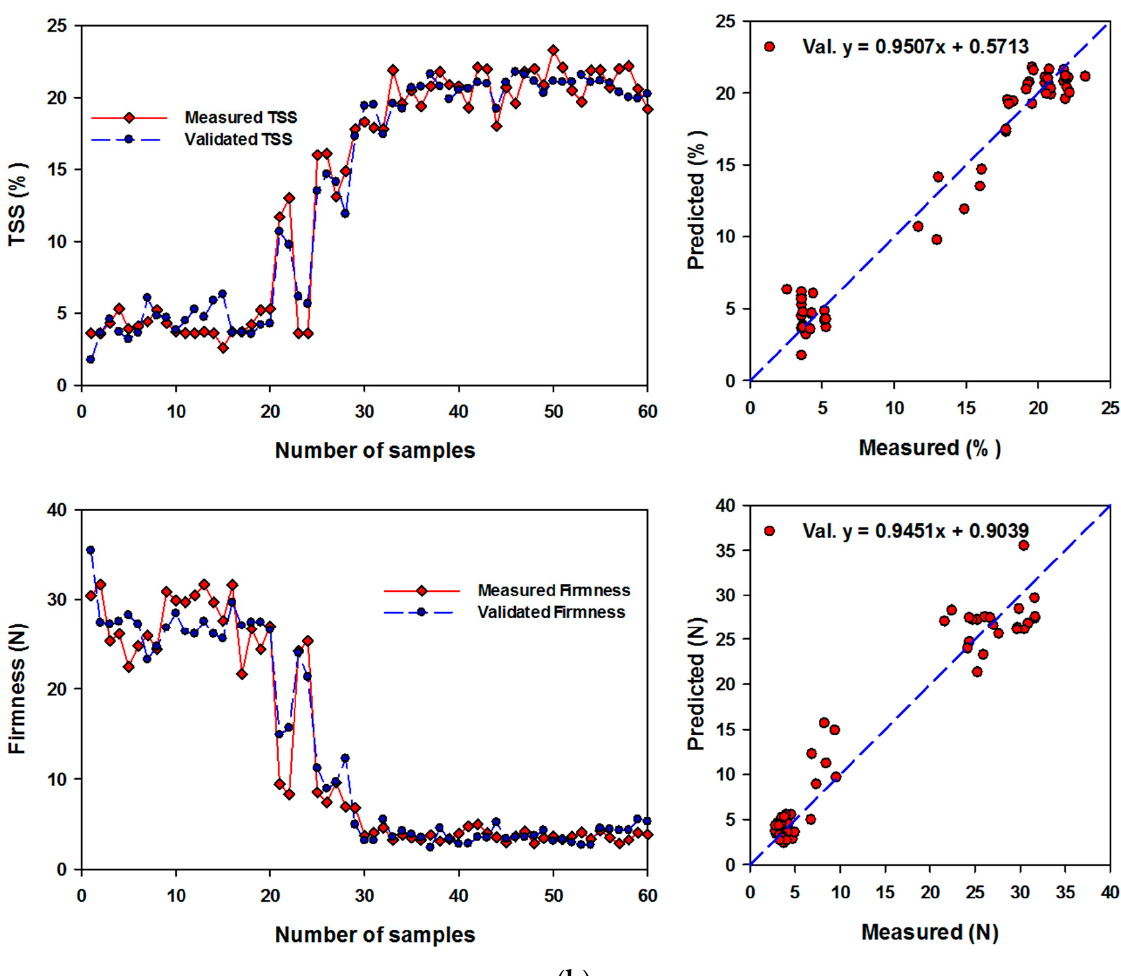
Figure 5. ( a ) Comparison between measuring datasets and validating datasets for Chl a, Chl b, and respiration rate (Rr) using the SVMR models. Statistical analysis was shown in Table 7. ( b ) Comparison between measuring datasets, validating datasets for TSS, and firmness using the SVMR models. Statistical analysis is shown in Table 7. Table 7. Results of SVMR calibration and validation models for the relationship between SRIs and Chl a, Chl b, respiration rate, TSS, and firmness of banana fruits.